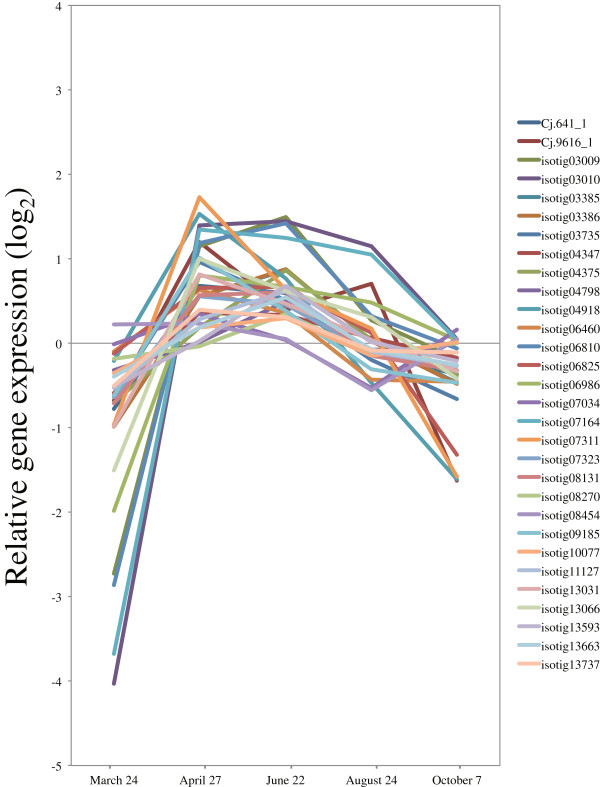
Expression of hemicellulose-related gene family in cambial region during xylem formation. The individual targets are summarized in Additional file 3. All expression data are presented on a log2 scale.